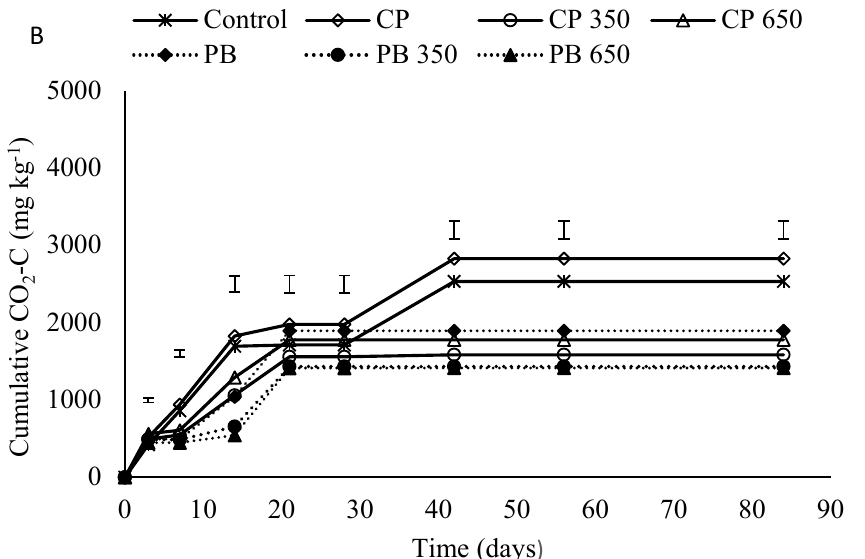
Figure 4. Cumulative CO 2 − C during incubation of Luvisol ( A ) and Ferralsol ( B ) amended with biochar from cull potato (CP) and pine bark produced at varying pyrolysis temperatures. CP = cull potato; PB = pine bark; CP 350 = cull potato biochar at 350 ◦ C; CP 650 = cull potato biochar at 650 ◦ C; PB 350 = pine bark biochar at 350 ◦ C; PB 650 = pine bark biochar at 650 ◦ C. The vertical error indicates LSD ( p < 0.05).